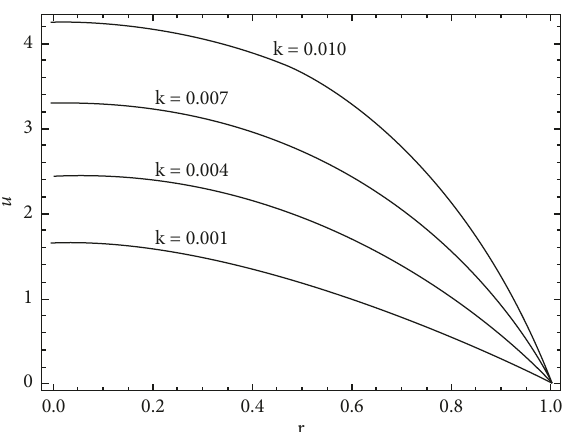
Figure 3: Variation of u with r for different values of K , where